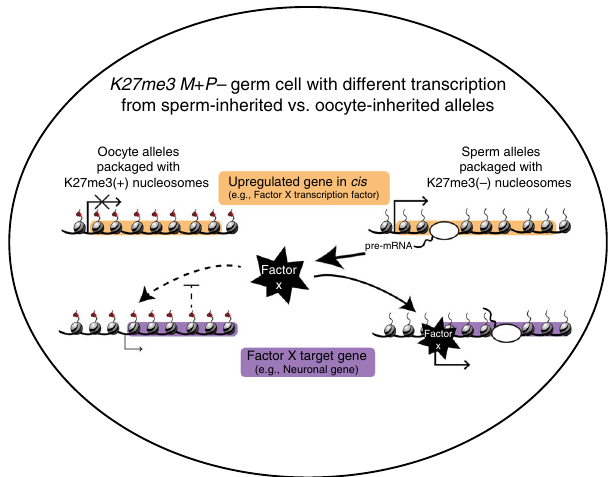
Fig. 4 A model for transcriptional upregulation in germ cells that inherited sperm chromosomes lacking H3K27me3. The schematic is a germ cell nucleus from a K27me3 M + P − worm showing oocyte-inherited and sperm- inherited alleles for 2 representative genes: a transcription factor-encoding gene (orange) and a target gene of that transcription factor (purple). Sperm-inherited alleles lack repressive H3K27me3 and as a result are prone to upregulate Transcription Factor X. If expressed, Transcription Factor X can then activate target genes strongly from H3K27me3( − ) sperm alleles and weakly from H3K27me3( + ) oocyte alleles. In this model, H3K27me3 would act as a barrier against (1) production of Factor X and (2) activation of Factor X target genes. In K27me3 M + P + worms, oocyte-inherited and sperm-inherited alleles are similarly marked with